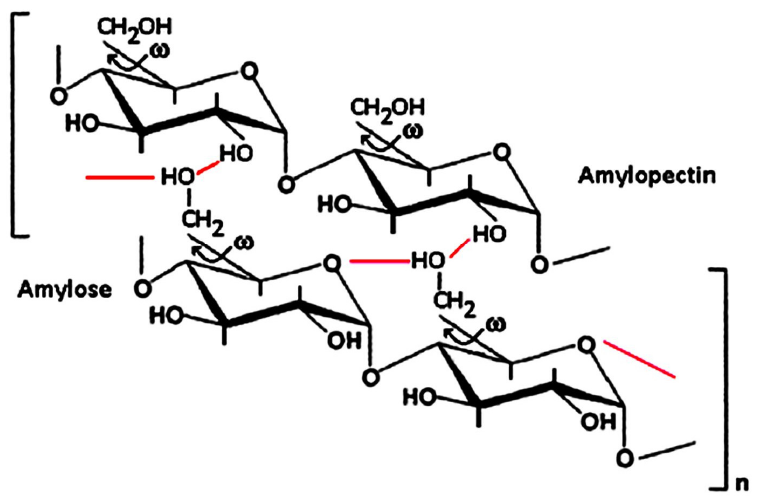
Scheme 4. Gelatinization mechanism of starch. The red lines represent hydrogen